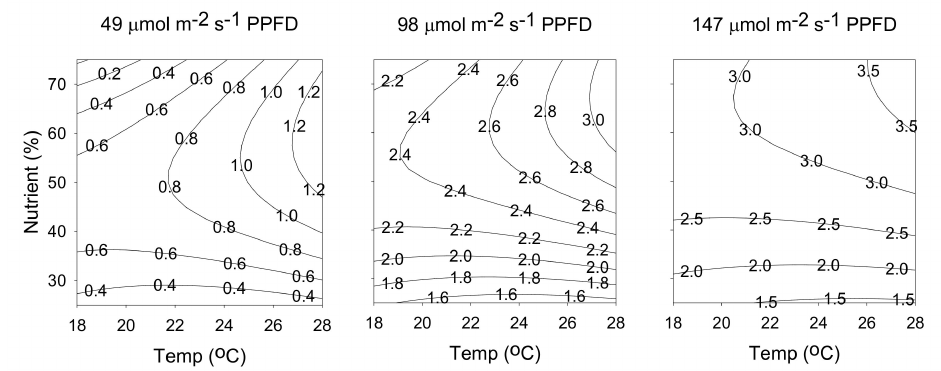
Figure 10. Contour plots of production yield of rutin. The numbers inside the contour plots indicate production yield (mg / plant) at given cultivated conditions.